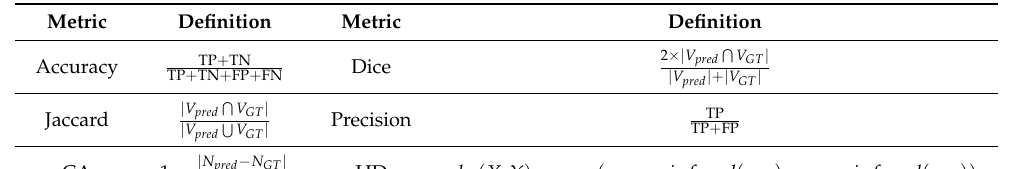
Table 2. The definitions of evaluation metrics. CA and HD are abbreviations of the Counting Accuracy and Hausdorff Distance, respectively.